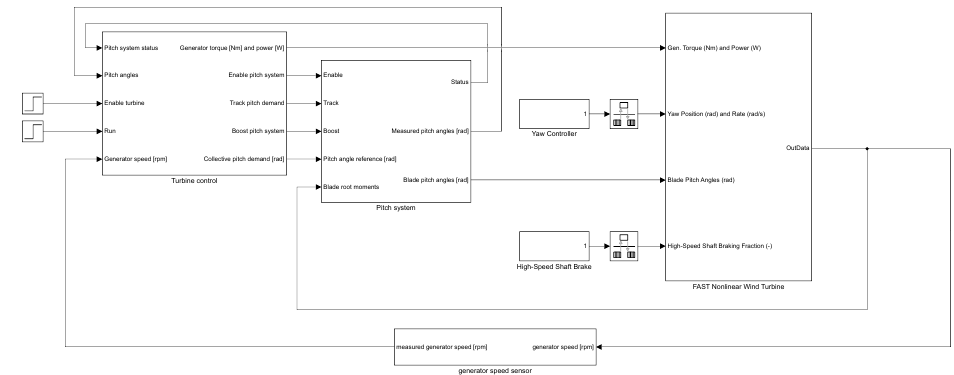
Figure 2. Aero-elastic and hydraulic models, with turbine control. Figure 2. Aeroelastic and hydraulic models, with turbine control.